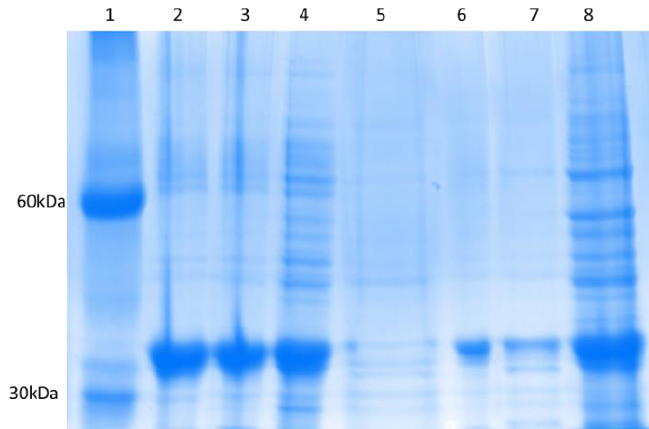
Figure 4. Modified Concanavalin (CNV44) Recovery. 1 = Molecular marker, 2 = Soluble fraction, 3 = Insoluble fraction urea 2M, 4–5 = Insoluble fraction urea 6 M.